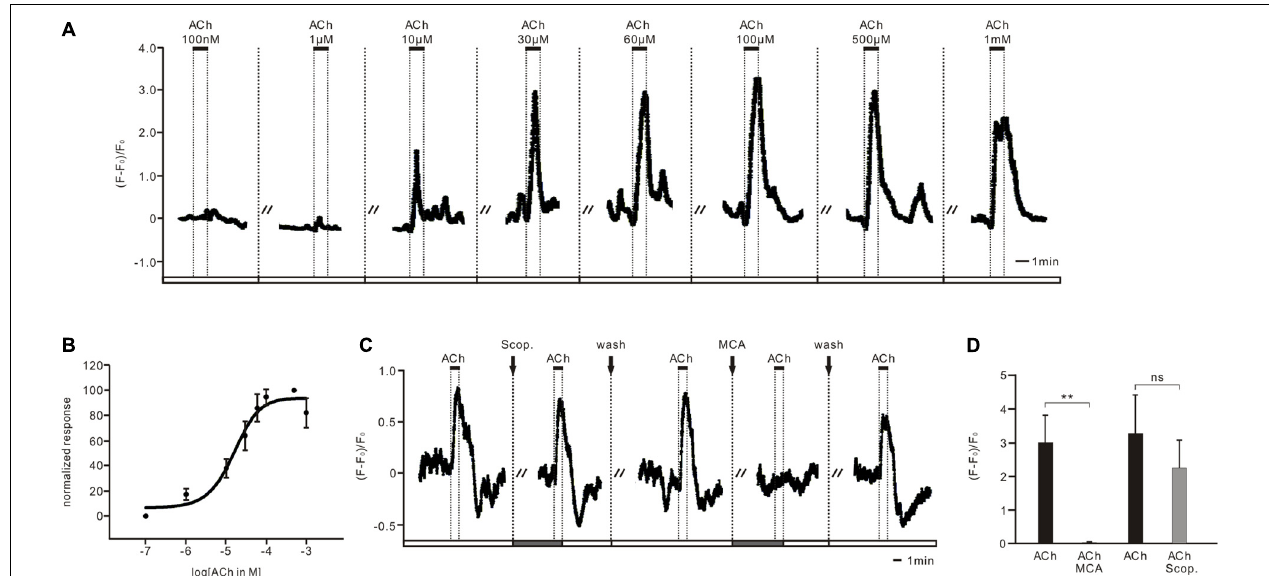
FIGURE 2 | Acetylcholine (ACh) increased dose-dependently intracellular Ca 2 + concentrations via a nicotinic but not a muscarinic ACh receptor in PTTH cells. (A) Ca 2 + imaging from ex vivo preparations of GCaMP6m-expressing PTTH cells revealed dose-dependent reversible increases in intracellular Ca 2 + levels after ACh application (100 nM–1 mM; n = 10). At higher concentrations of ACh, intracellular calcium levels of PTTH cells expressed fast desensitization. (B) Normalized ACh dose–response curve. EC 50 = 22.65 µ M. Data were plotted as mean ± SE. (C) ACh responses could not be blocked through pre-incubation (5 min) with the muscarinic ACh receptor antagonist scopolamine (Scop, 100 µ M). Instead, pre-incubation (5 min) with the nicotinic ACh receptor antagonist mecamylamine (MCA, 100 µ M) blocked all ACh responses ( n = 10). Dashed lines display separated consecutive stimulus applications of 5 min washes or antagonist applications. Solid bars indicate the duration of 1 min ACh application. (D) Increased calcium level in PTTH neurons in response to ACh was significantly blocked after MCA treatment ( n = 8), but not affected by Scop treatment ( n = 4). ** p < 0.01; ns, not significant p >